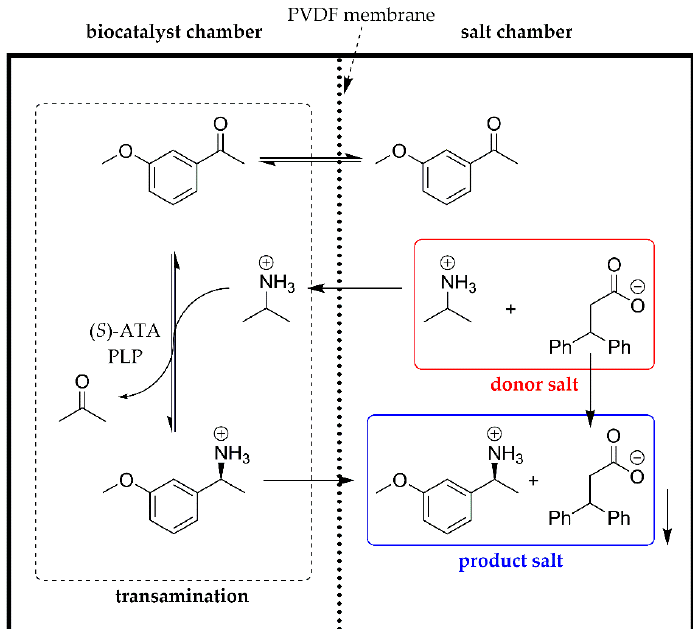
Figure 4. Reaction flow in the membrane reactor.